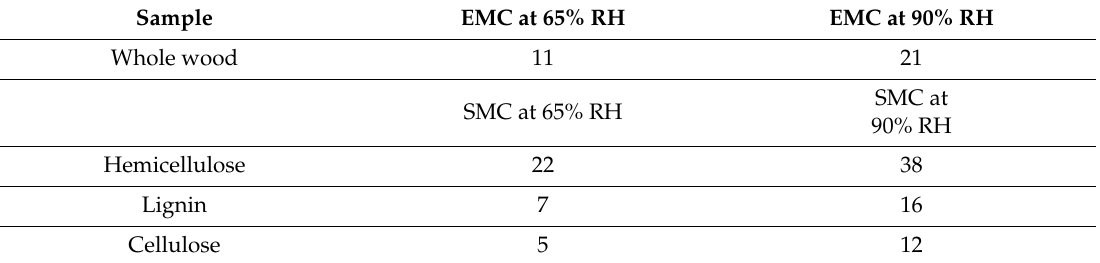
Table 3. Equilibrium moisture content and specific moisture content of whole wood and isolated cell wall polymers.